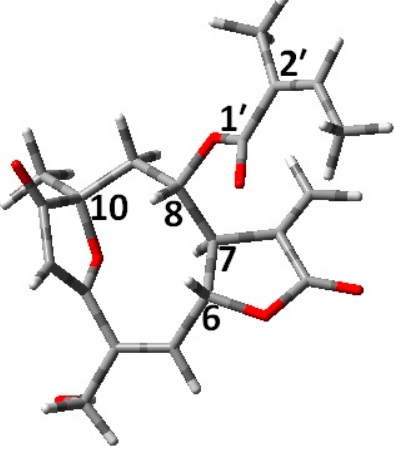
Figure 1. The (6 R ,7 R ,8 S ,10 R ,2’ Z ) structure of centratherin [26].